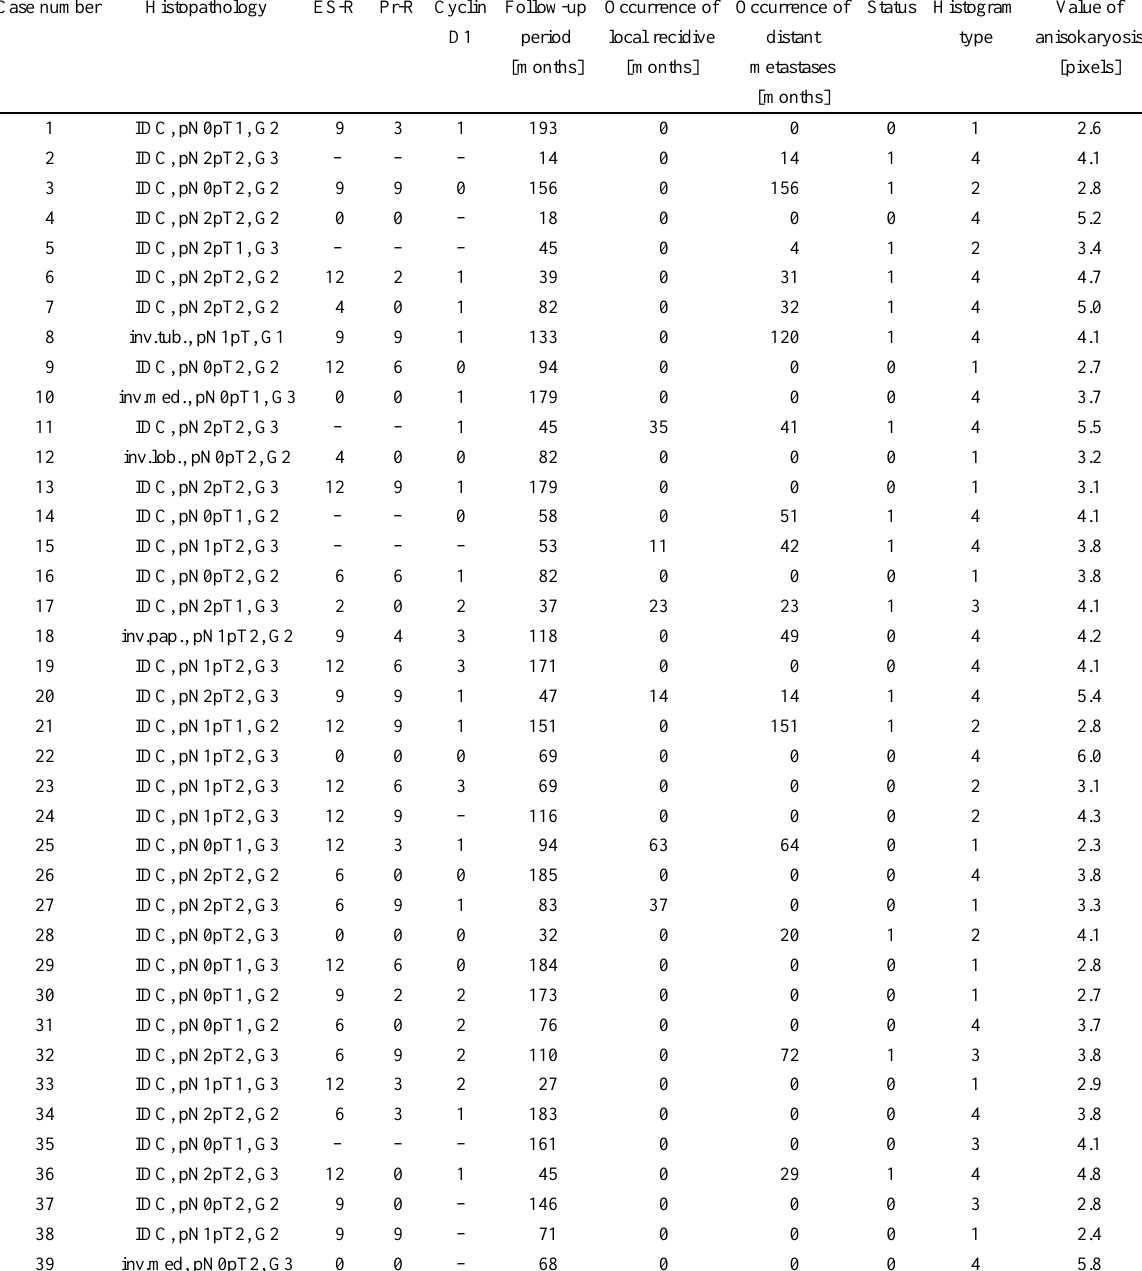
Histopathological characteristics, immunohistochemical and cytometrical parameters as well as follow-up data of the 39 breast cancer